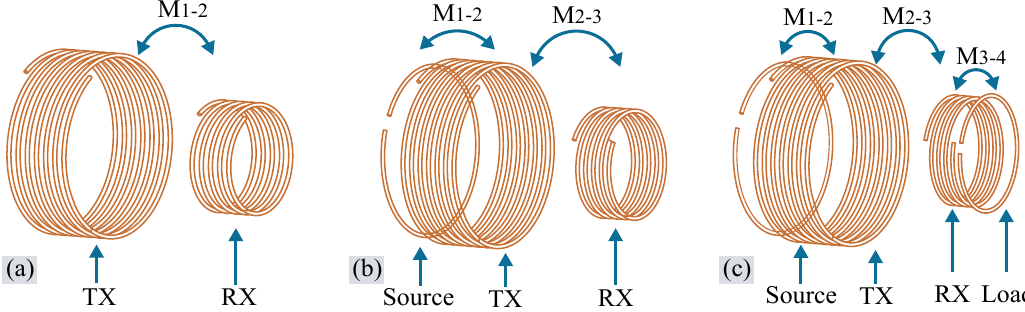
Figure 1. Block diagram of ( a ) 2-coil; ( b ) 3-coil; ( c ) 4-coil WPT